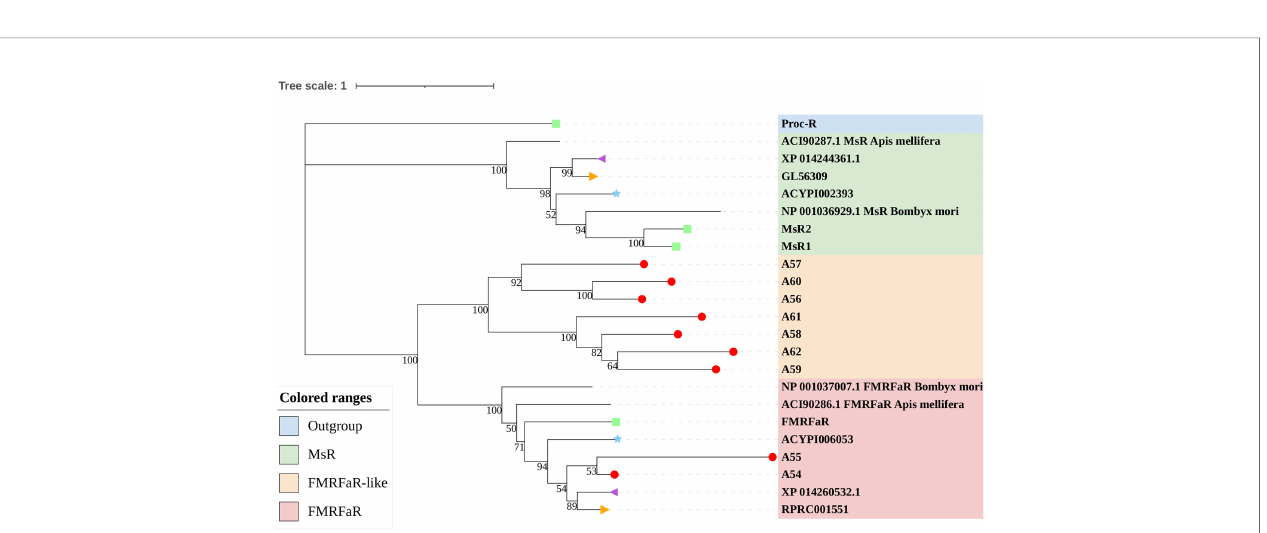
FIGURE 7 | Phylogenetic tree reconstruction of FMRFaRs and MsRs from D. melanogaster (green square), A. pisum (blue star), R. prolixus (orange right triangle), C. lectularius (purple left triangle), A. lucorum (red circle), and other two model insects inferred from maximum likelihood (ML) analysis. Numbers at nodes on the tree were the bootstrap values. The tree was rooted by the D. melanogaster